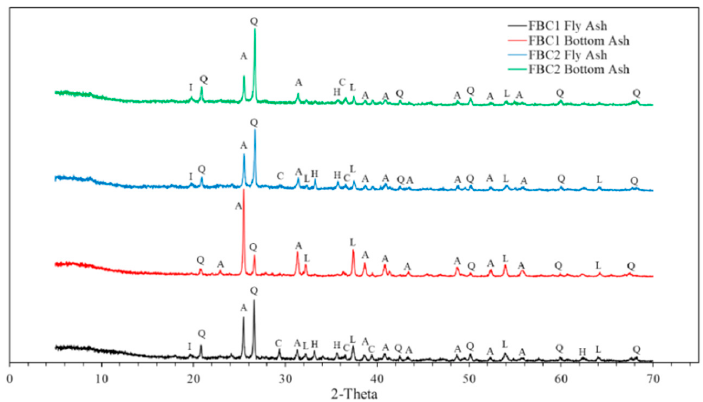
Figure 6. XRD patterns of the fluidized bed combustion (FBC) ash samples: A, anhydrite; C, calcite; H, hematite; I, illite; L, Lime; and Q, Quartz. [53]